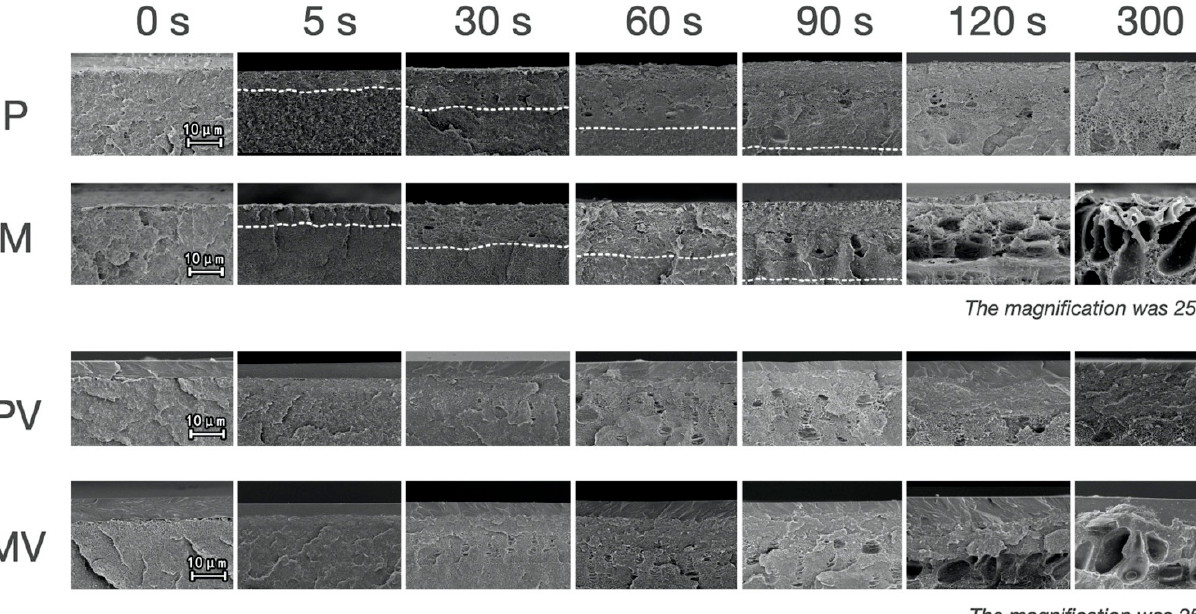
Figure 4. The SEM images showing the cross-section morphology of the etched PEEK before and after the treatment of the bonding primer at × 2500 magnification. P : etched printed PEEK; M : etched printed PEEK; PV : etched printed PEEK with the treatment of the primer Visio.link; and MV : etched milled PEEK with the treatment of the primer Visio.link. The dotted lines indicate the bottom of the etched pores. For overall views of the etched pores of the groups (etching duration 120 s and 300 s), the SEM images ( × 1000 magnification) were further supplied in Figure